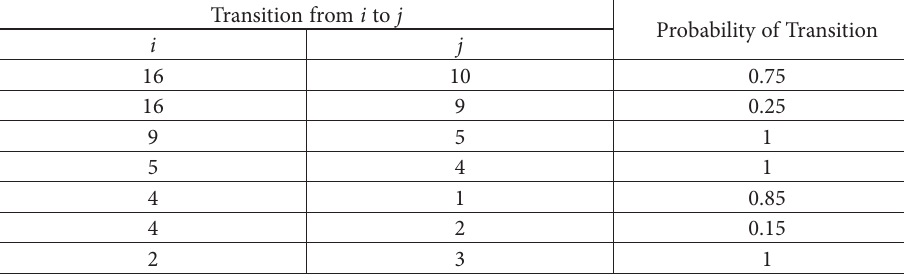
Table 10. Probabilities of transitions – partial ignorance case